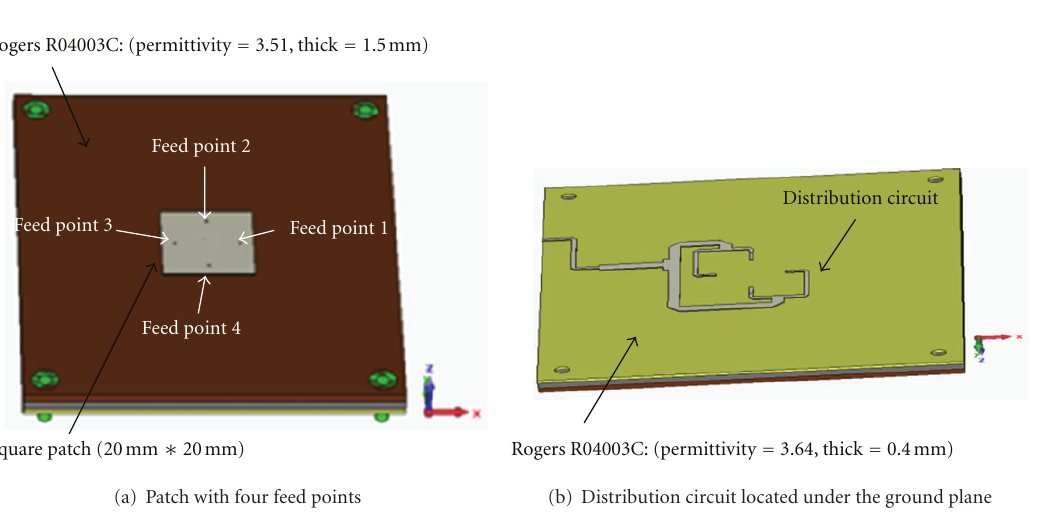
Figure 2: Feed system of the designed antenna.